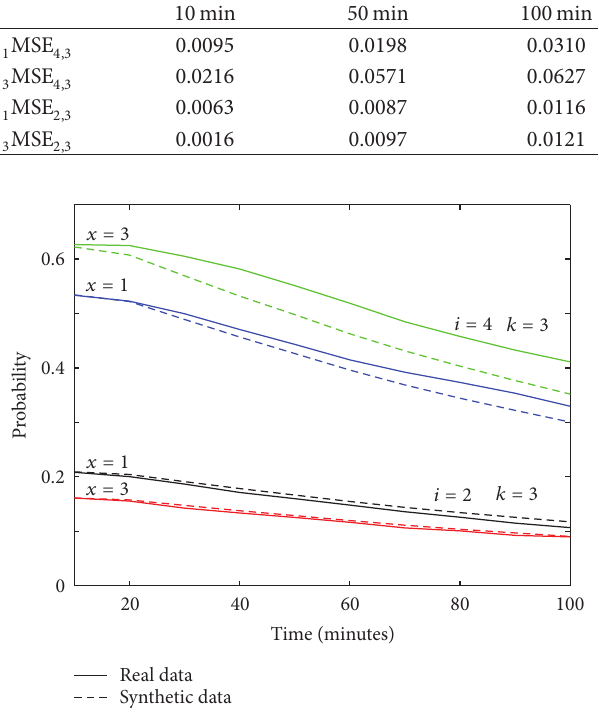
F 3: Comparison of reliability functions for real and simulated data.